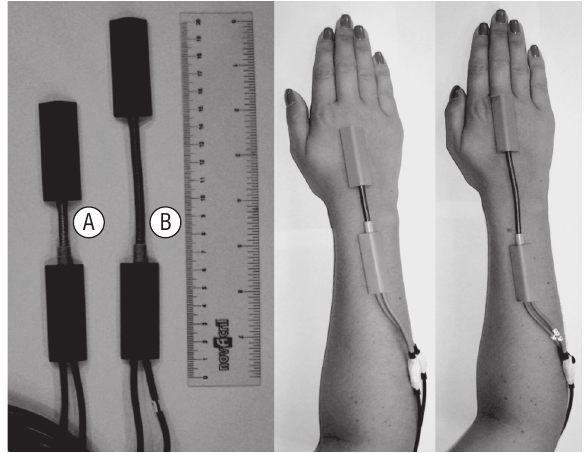
Figura 1 - Sensores XM65 (A) e XM110 (B) e acoplamento dos eletrogoniômetros no punho do indivíduo Fonte: Dados da